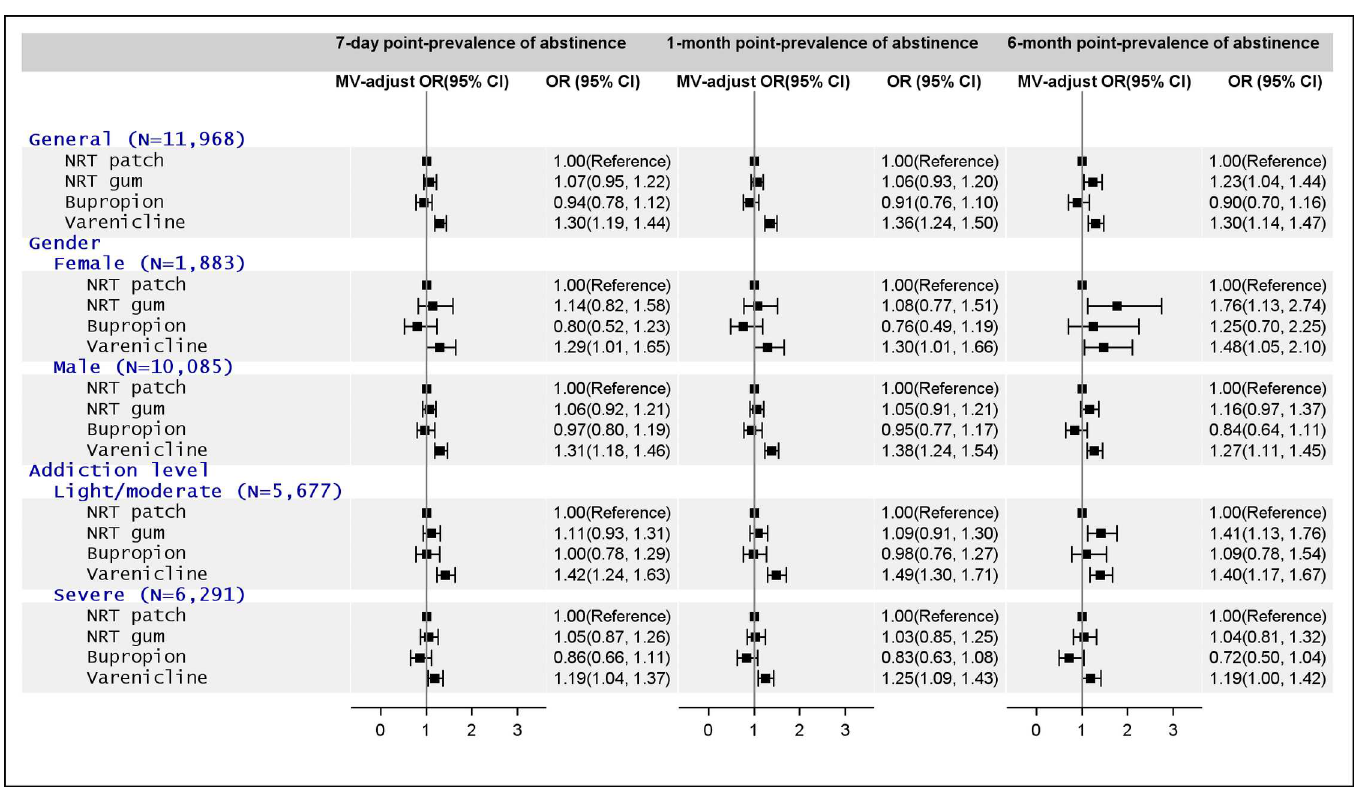
Fig 2. Relative effectiveness of smoking cessation medications for point-prevalence of abstinence after 6 months, with stratifications by sex and nicotine dependence level. a Models included: age, sex, education, marital status, geographicarea, medical institution, nicotinedependence level, smoking years, smoking cessation clinic visit and medicationuse duration. Sex and nicotine dependence level was not includedin analysesstratified by the covariate. MV-adjust , multivariable-adjusted; OR , odds ratio; CI , confidenceinterval; NRT , nicotinereplacement